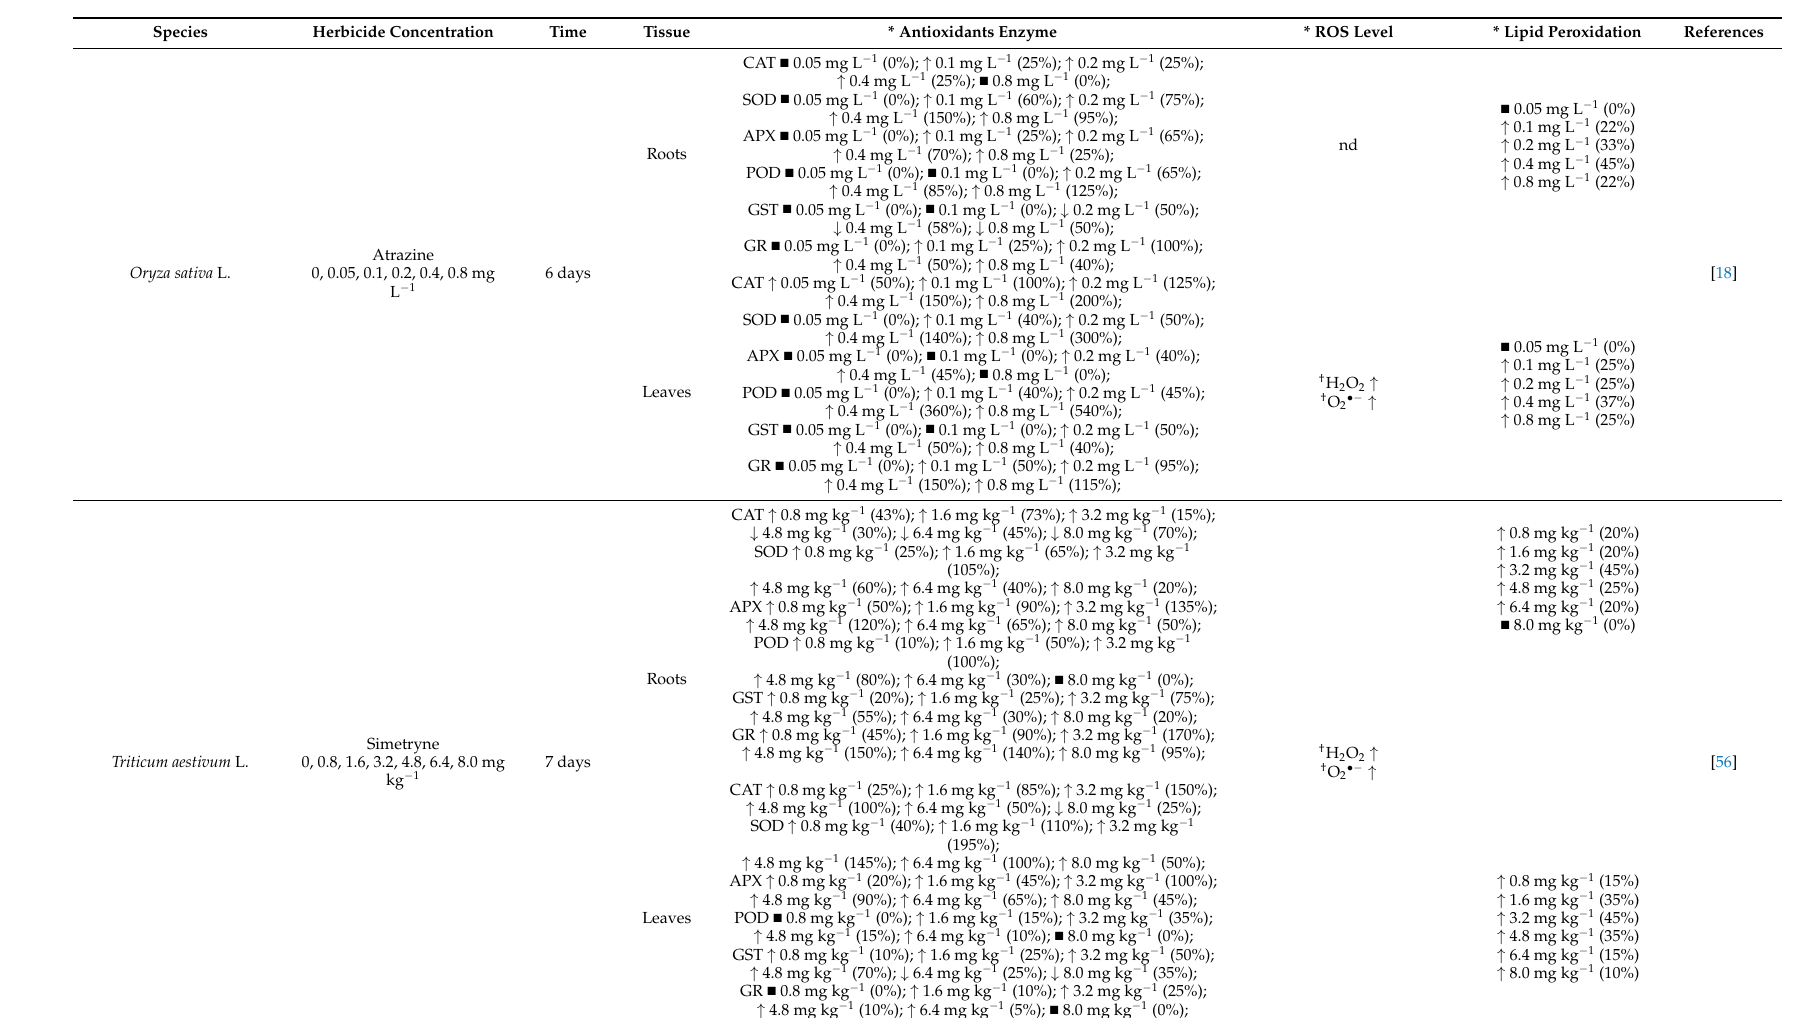
Triticum aestivum